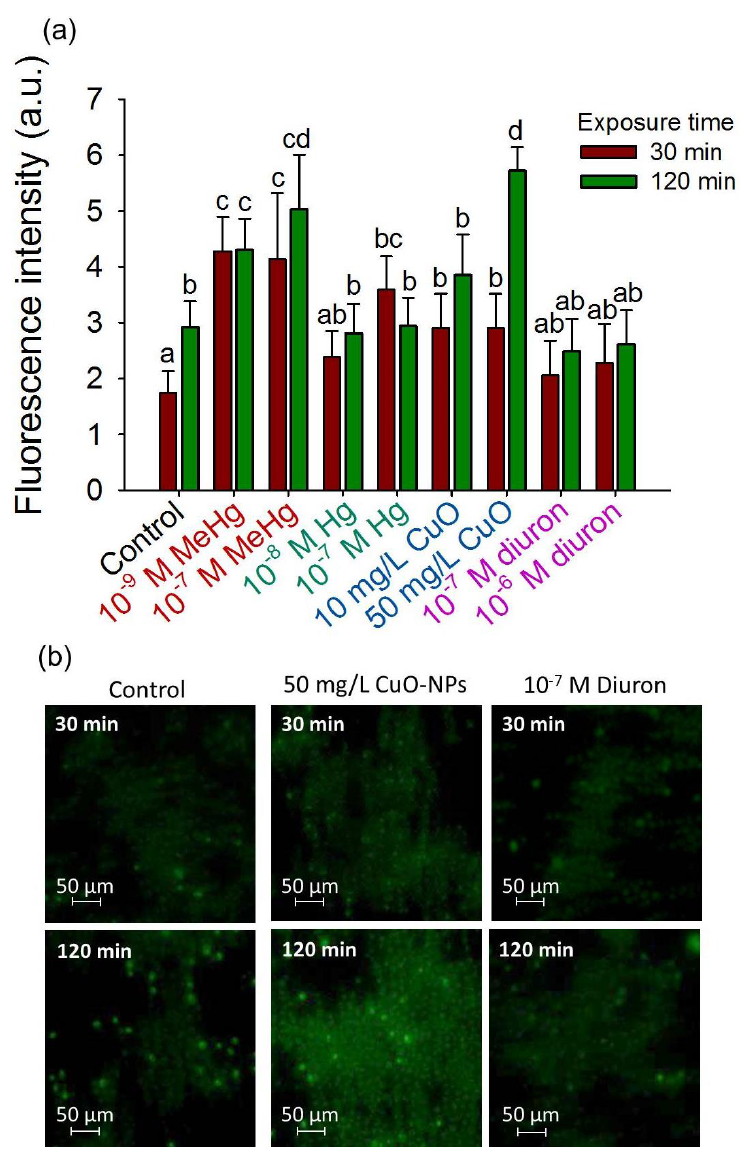
Figure 6. 2D-cell array sensing of oxidative stress during short-term exposure to contaminants. ( a ) Mean corrected CellROX ® fluorescent intensity ( CF ) for different contaminants; Different letters indicate significant differences between means ( p <